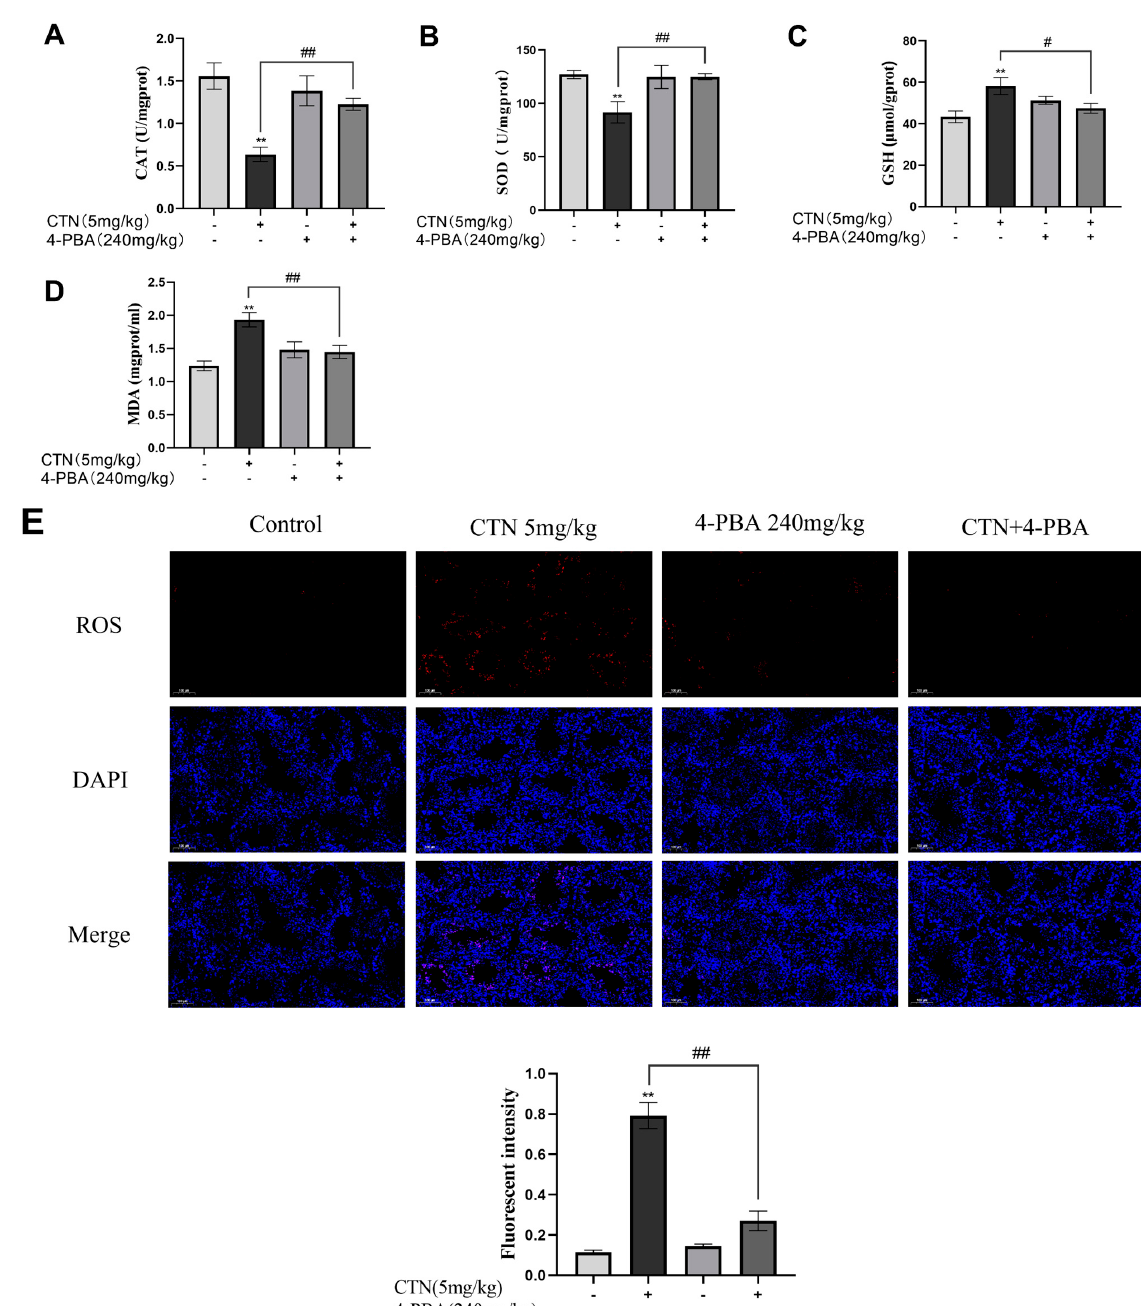
Figure 7. The effects of 4-PBA on CTN-induced testicular oxidative damage in mice. ( A ) CAT activity; ( B ) SOD activity; ( C ) GSH content; ( D ) MDA content; ( E ) ROS content in testicular tissue; scale bar in figure: 100 µ m. The above data are expressed as SEM ± mean, ** p < 0.01, compared with the control group, # p < 0.01, ## p < 0.01, compared with the CTN group. 3.8. E ff ects of 4-PBA on Blood Testis Barrier (BTB) Damage after CTN Exposure Compared with the control group, after exposure to CTN, the expression of tight junction proteins occludin and claudin-1 was signi fi cantly reduced (Figure 8A, p < 0.01), and the results of immuno fl uorescence detection showed that the fl uorescence intensity of ZO-1 was signi fi cantly downregulated (Figure 8B, p < 0.01). In addition, the transmis- sion electron microscopy results showed that the TJ indicated by the arrow in the CTN group showed blurred structure compared with the blank group, which indicated that the BTB-related structures in the testis were damaged (Figure 8C). The BTB damage caused by CTN was reversed after 4-PBA pretreatment.